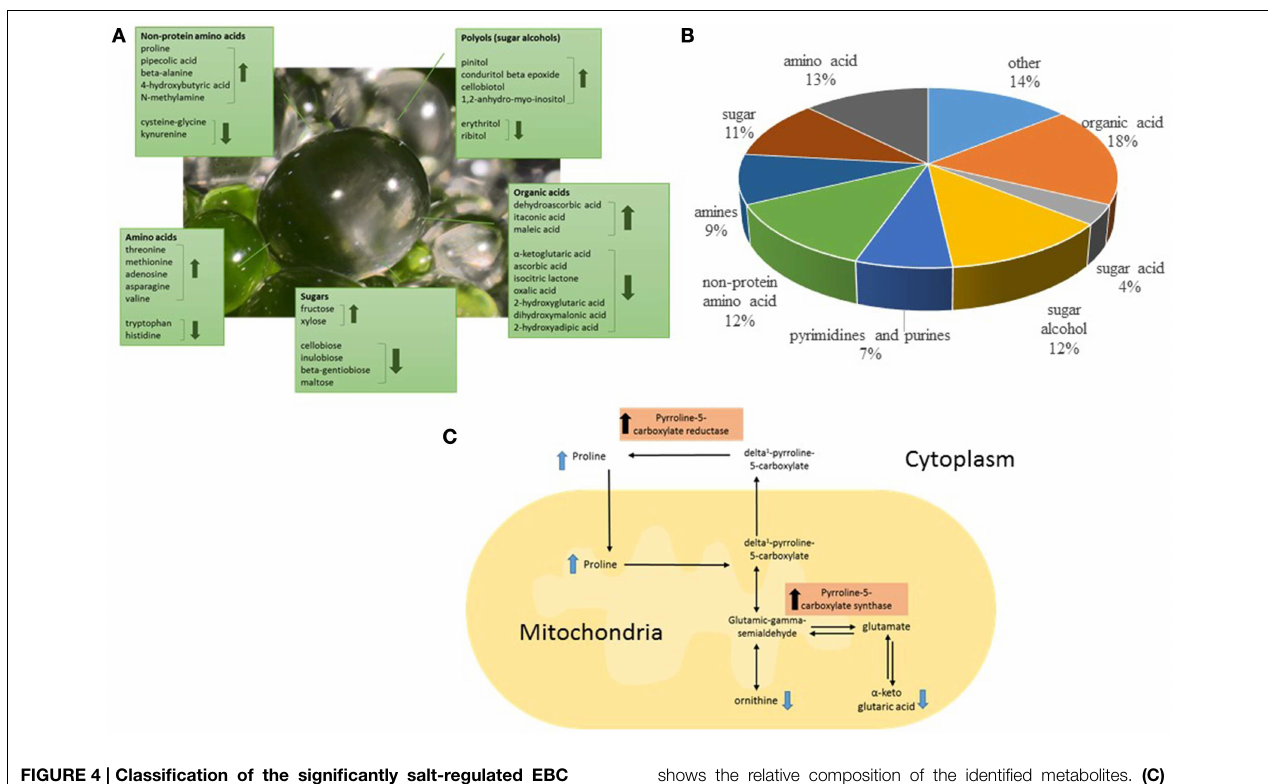
FIGURE 4 | Classification of the significantly salt-regulated EBC metabolites based on their known function and chemical attributes. (A) A large proportion of the identified metabolites could have roles as compatible solutes in the EBC, including those classified as amino acids, sugars, organic acids, and polyols. (B) The pie graph